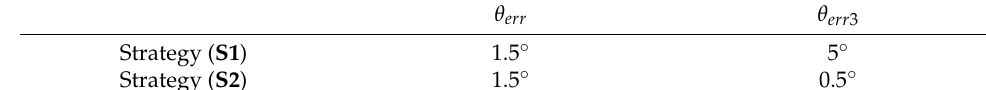
Figure 21. Simulation waveforms at 78 rad/s of position errors resulting from ( S1 ) and ( S2 ): ( a ) error on the angle required to control MM, ( b ) error on the angle required to control SM.